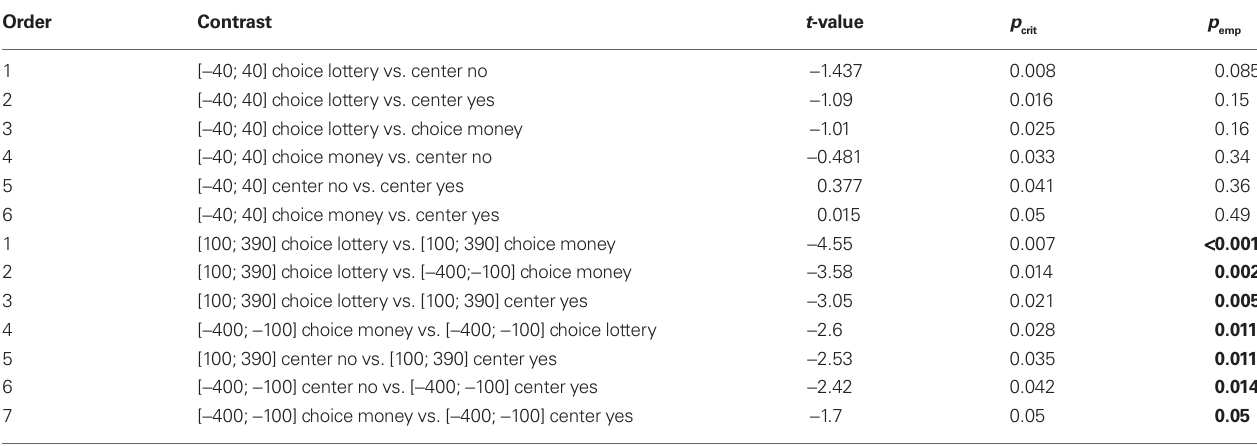
Table 2 | Ordered p -values for the comparison of the mean ERN amplitudes between